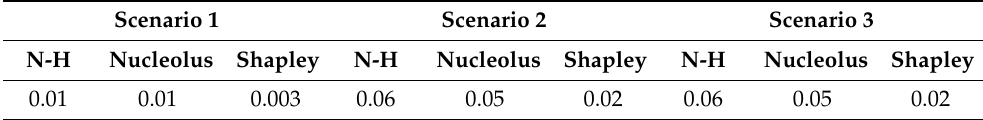
Table 6. The power index of the proposed solutions under different scenarios.